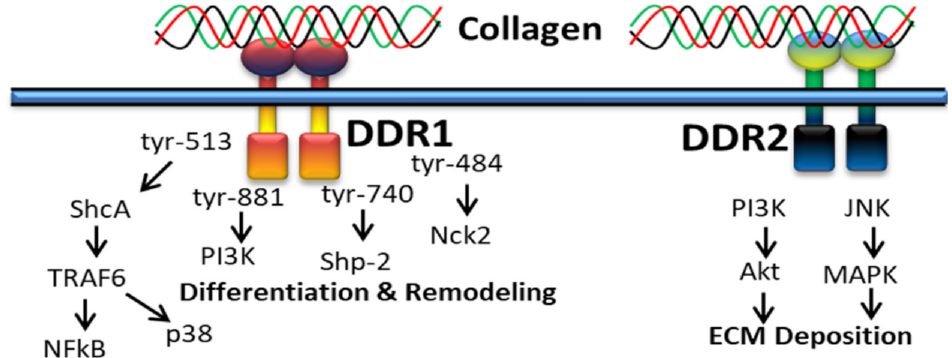
Figure 5. Collagen DDR signals in ECM